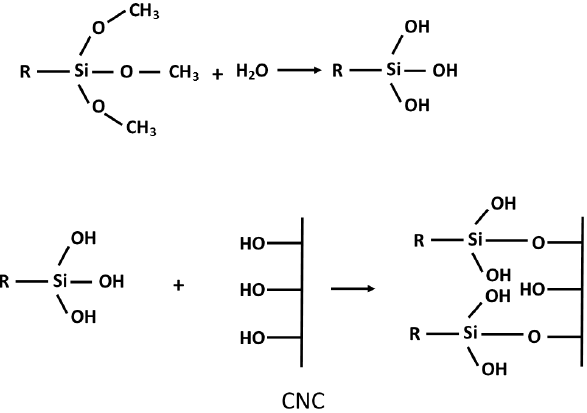
Figure 6: Schematic for silane reacting with hydroxyl surface groups of